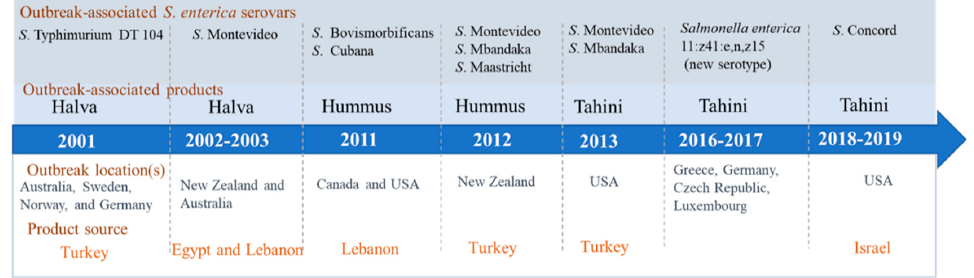
Figure 1. Salmonella outbreaks associated with the tahini or tahini-based